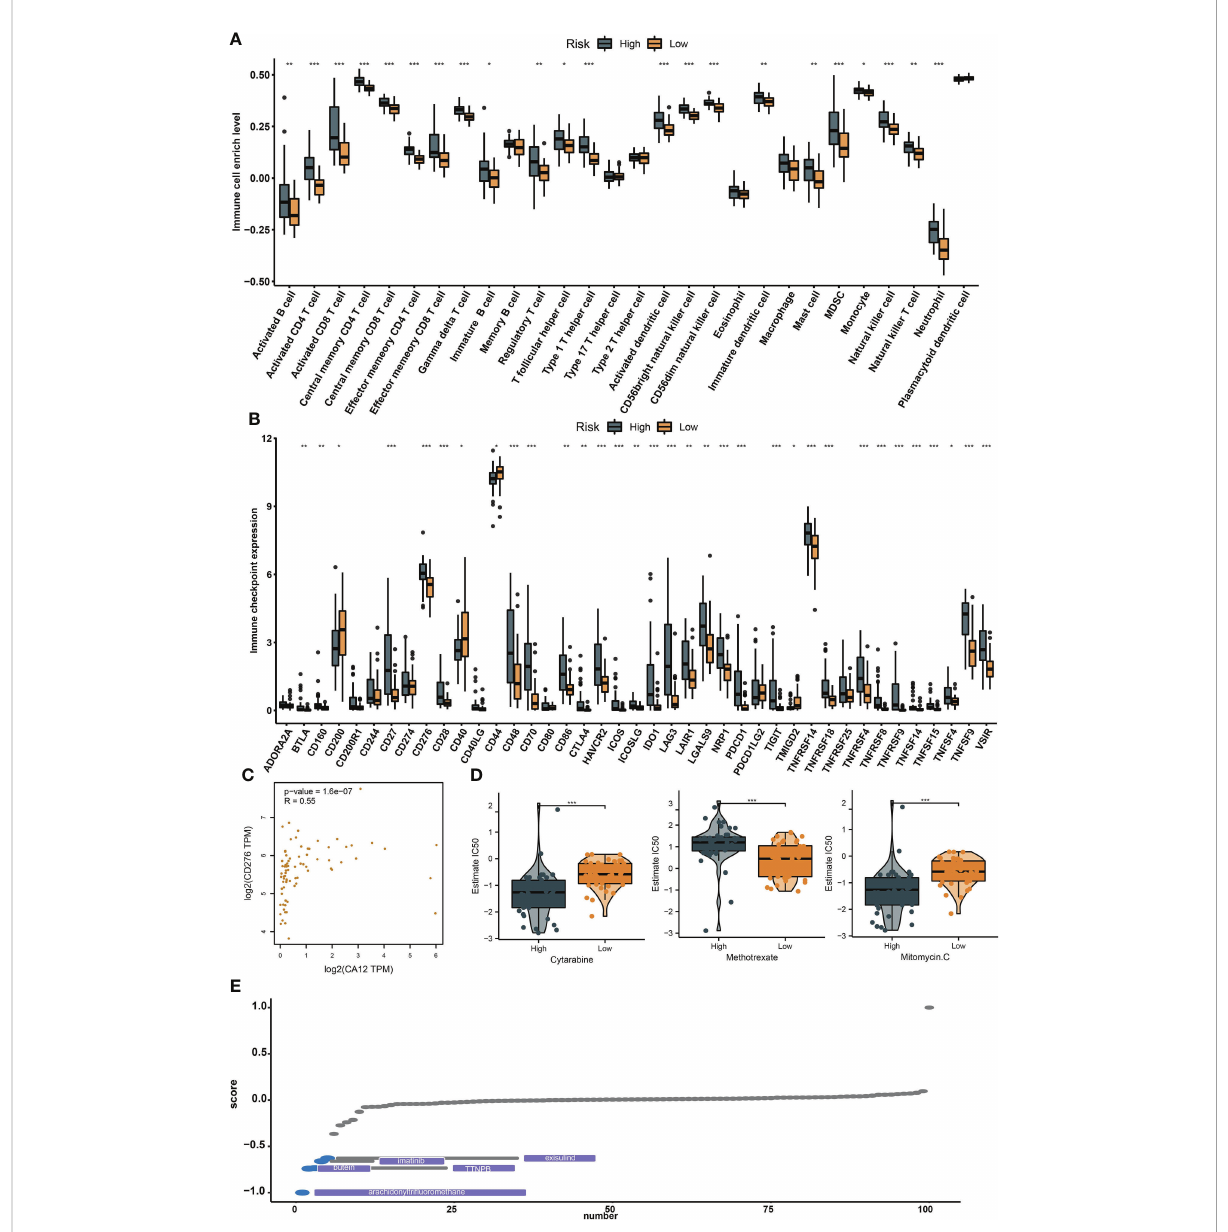
FIGURE 7 The immunological diversity between the risk groups and drug development. The box plots show the in fi ltration differences of immunocytes (A) and immune checkpoint differences (B) between the risk groups. (C) The correlation between CD12 and CD276 expression. (D) The IC50 level differences between the risk groups for the GDSC drugs. (E) Identi fi cation of potential effective drugs from the cMap database, *, **, *** represents p-value < 0.05, 0.01, and 0.001,